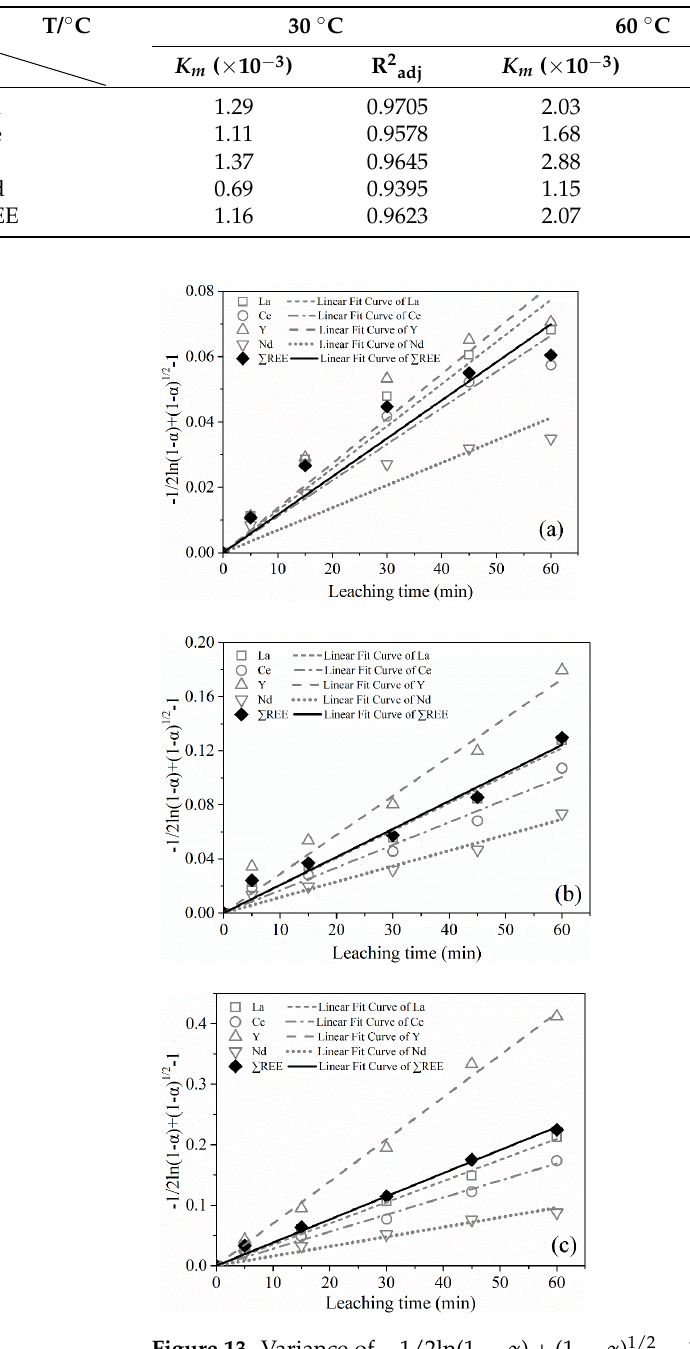
Table 6. K m and R 2 adj for the SCM of interfacial transfer and diffusion control based on cylindrical particles.